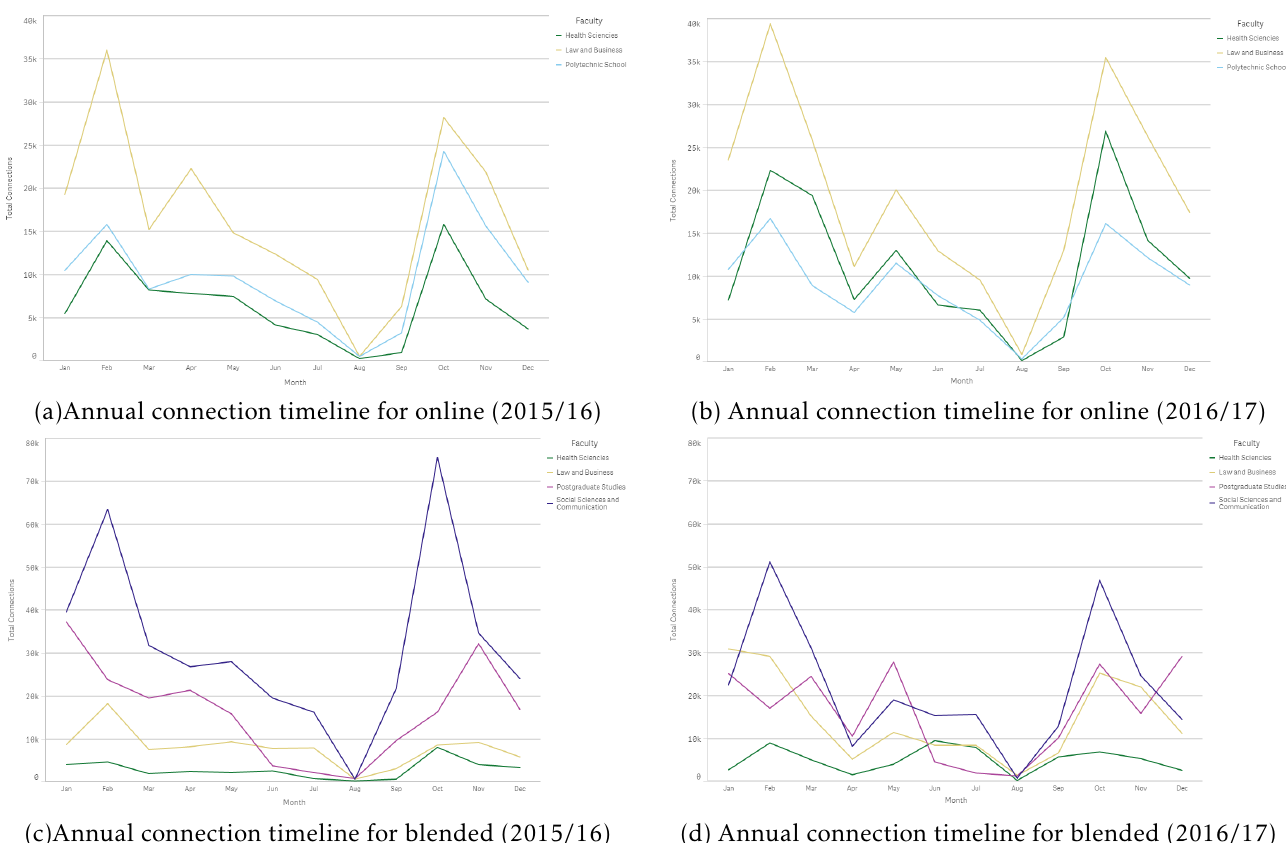
Figure 6. Annual trends in lecturers’ log-ins for faculties with online and blended